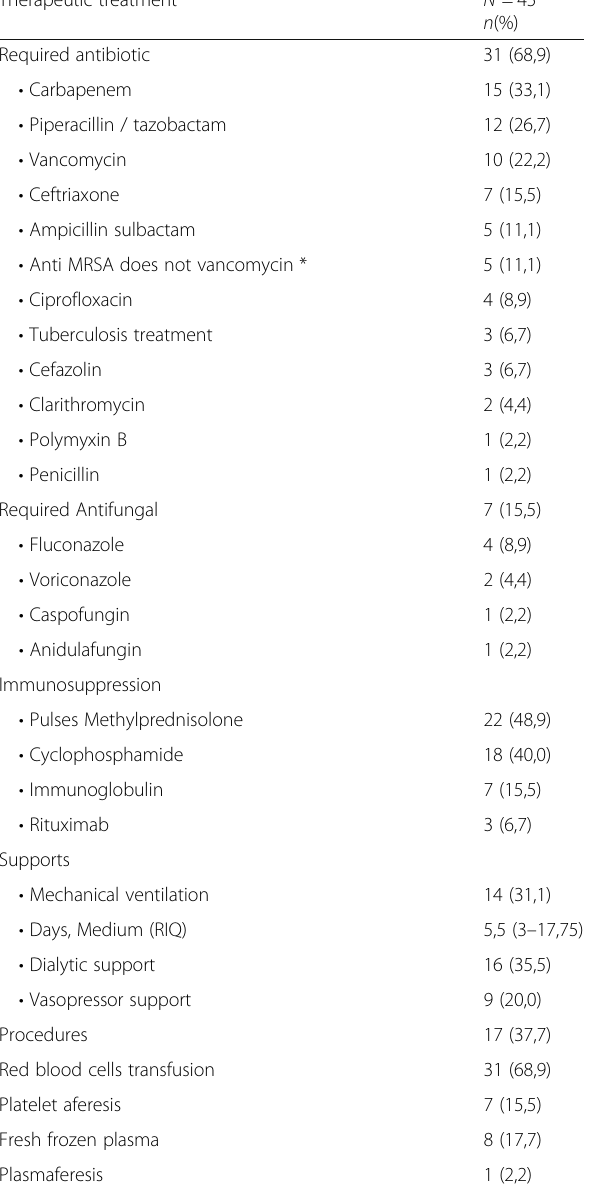
Table 6 Therapeutic management during the stay in the ICU Therapeutic